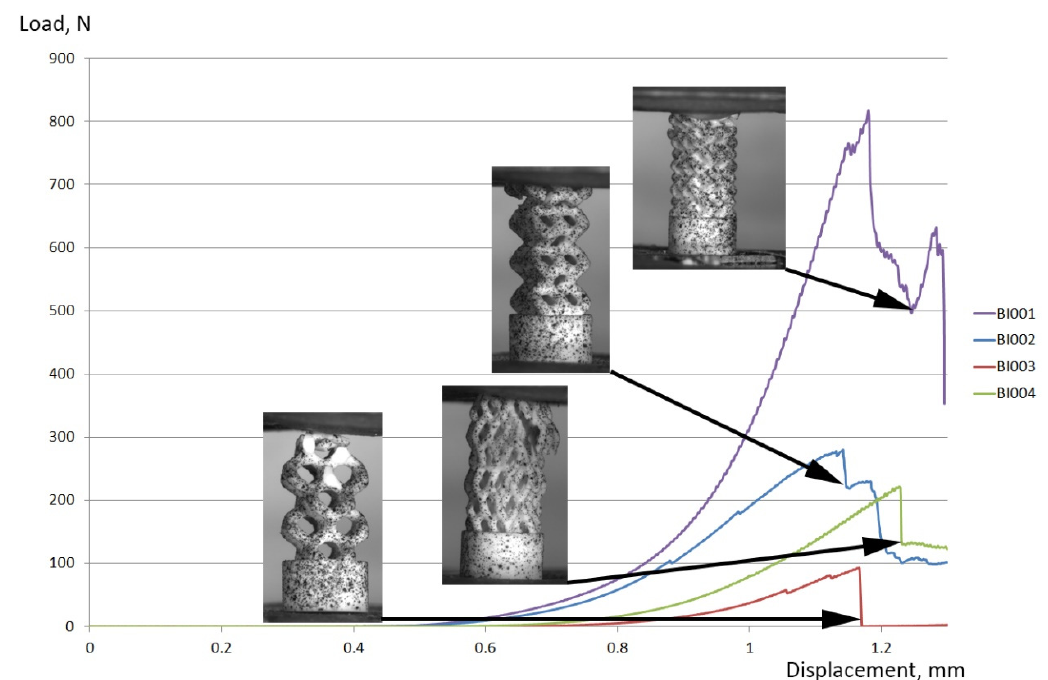
Figure 12. Loading curves for implant specimens tested under axial compression. The crosshead travel (mm) during testing is plotted on the horizontal axis; the load (N) is plotted on the vertical axis.